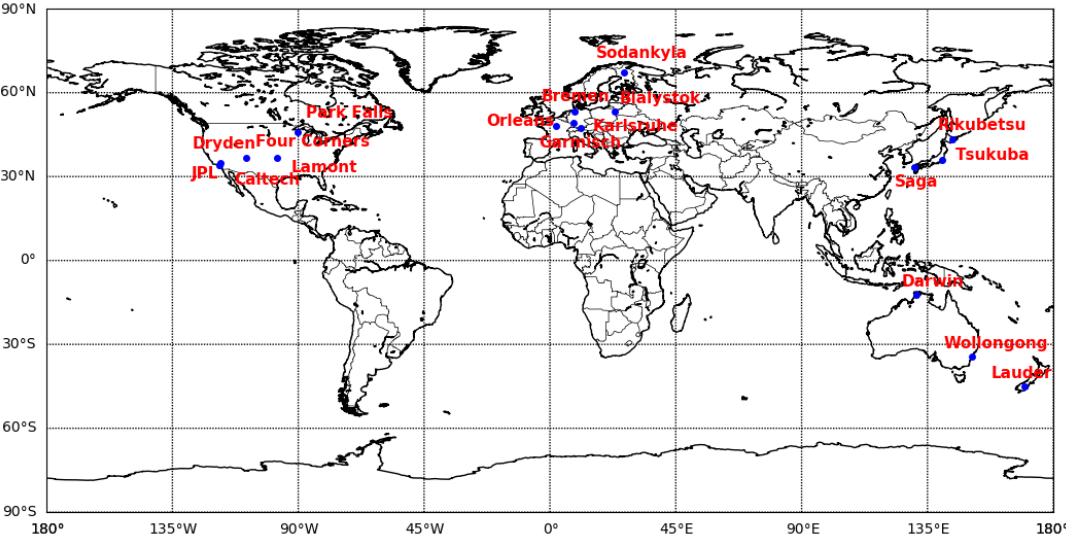
Figure 1. Global map of the ground-based Total Carbon Column Observing Network (TCCON) sites used for correction and validation of Greenhouse Gases Observing Satellite (GOSAT) data.